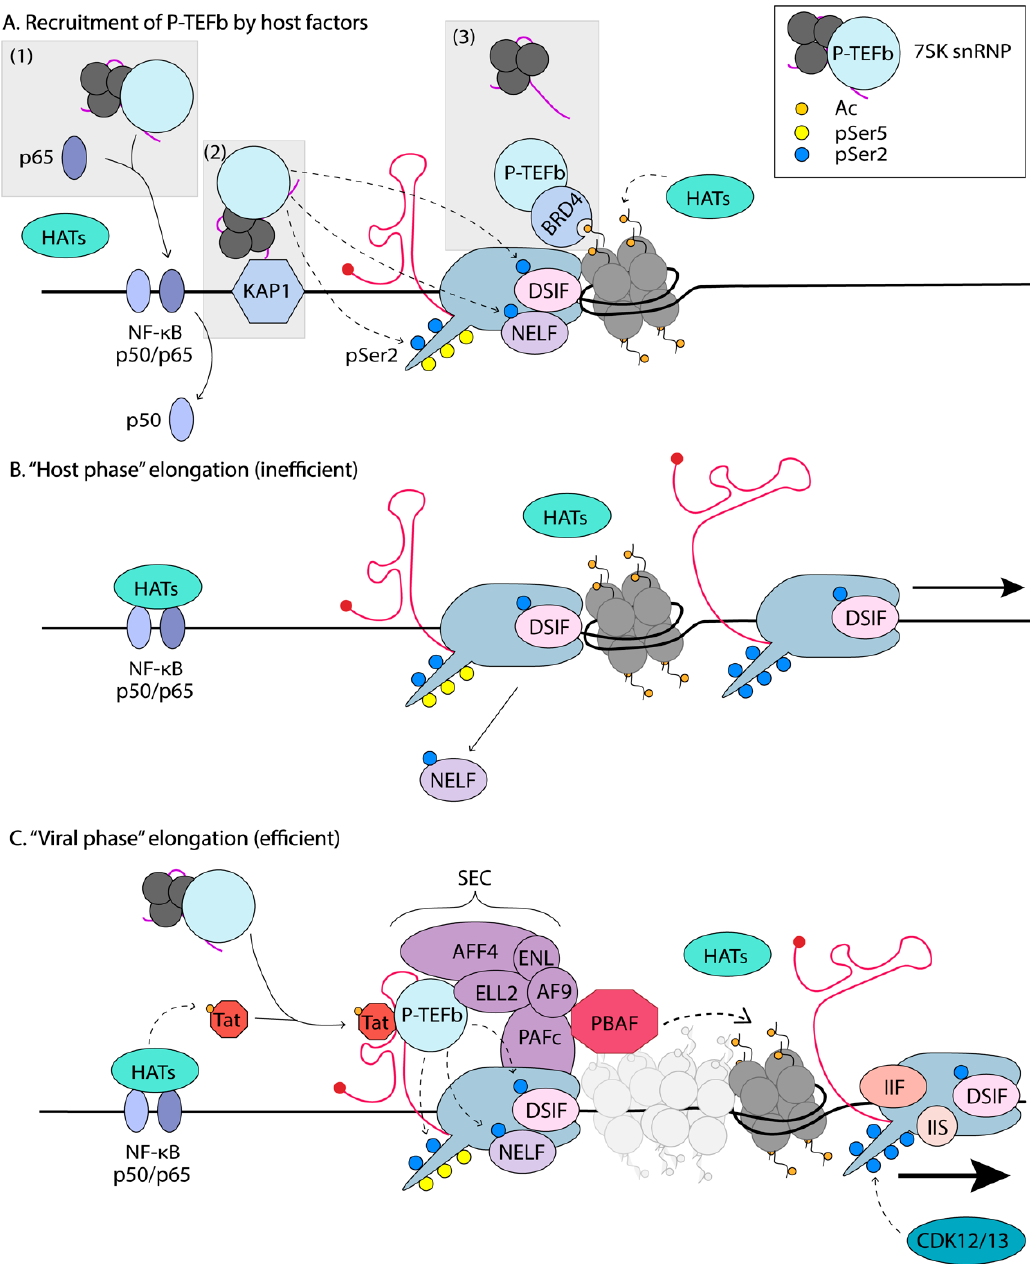
Figure 4. Regulation of transcription elongation. ( A ) In activated cells, in the absence of Tat, TFs such as the NF- κ B p65 subunit translocate to the nucleus and bind to their consensus sequence. In this process they displace transcriptional repressors, e.g. p50 homodimers and associated HDACs. P-TEFb is recruited (shown by the grey boxes) to the paused RNAPII at promoters, through either a direct interaction with p65 ( 1 ), indirectly through recruitment of the 7SK snRNP to promoter DNA by KAP1 ( 2 ) or through extraction from the 7SK snRNP by BRD4, which binds to acetylated histones ( 3 ). Once in the proximity of the paused RNAPII, the CDK9 subunit of P-TEFb phosphorylates Ser2 residues on the RNAPII CTD, as well as NELF (releasing it from RNAPII) and DSIF (converting it to an elongation factor). ( B ) In the absence of Tat, the recruitment of P-TEFb is ine ffi cient and results in limited transcription elongation (due to the repressive Nuc-1 positioning), but ultimately leads to a production of some full length HIV-1 mRNAs, which are spliced to produce all transcripts for the proteins that are necessary for the viral lifecycle, including Tat. The level of full-length mRNA production in this “host phase” is dependent on the availability of host TFs, such as NF- κ B and